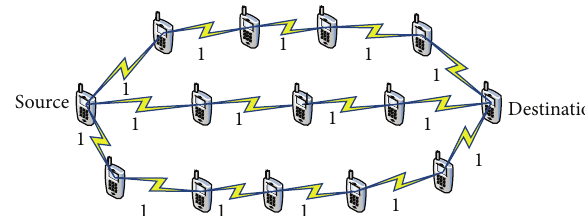
Figure 1: MP-OLSR multiple paths in initial state cost function.